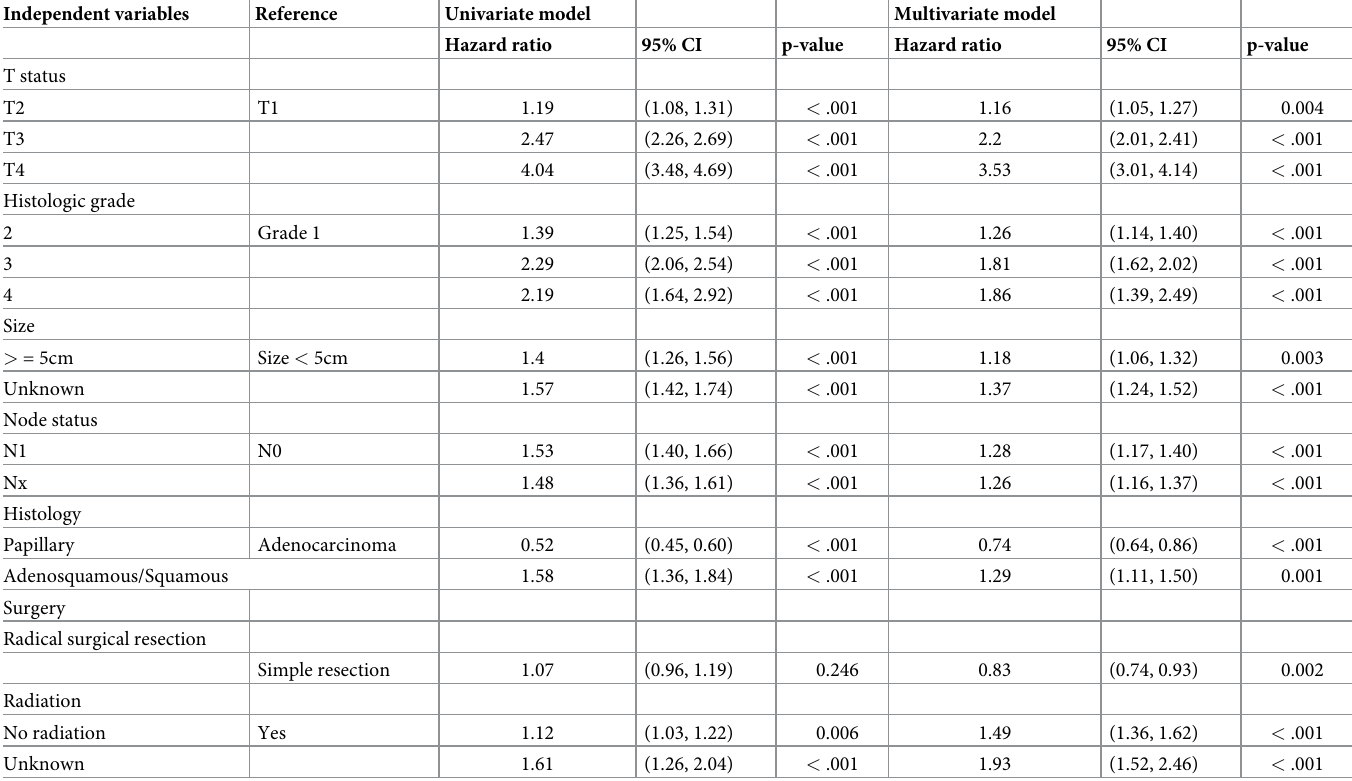
Table 2. Univariate and multivariate analysis model for overall